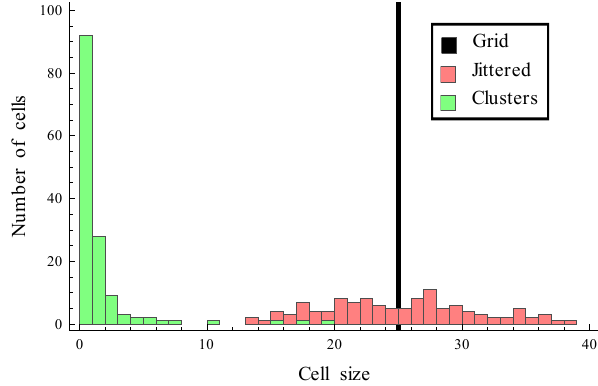
Figure 2. Tile size distribution for jittered and clustered sampling. The jittered sampling is peaked around the grid cell size, with clus- tered sampling results in many small and few very large tiles. Note that grid and jittered grid have twice as many nodes as the clustered sampling.